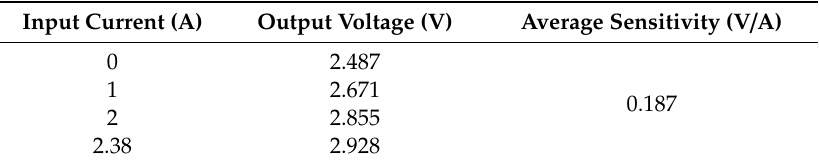
Table 1. Test result of photovoltaic (PV) current sensor.